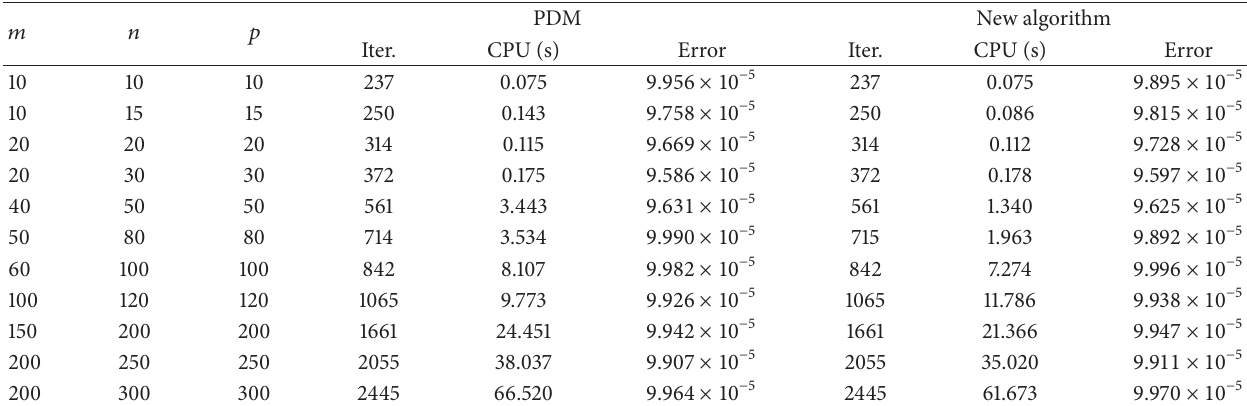
Table 1: Numerical results for the